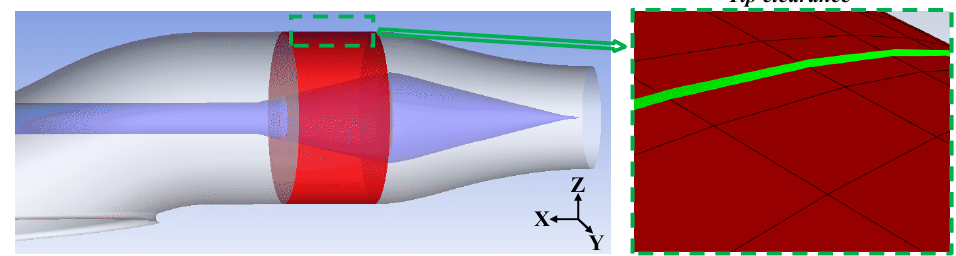
Figure 6. Geometry used with body-force model.